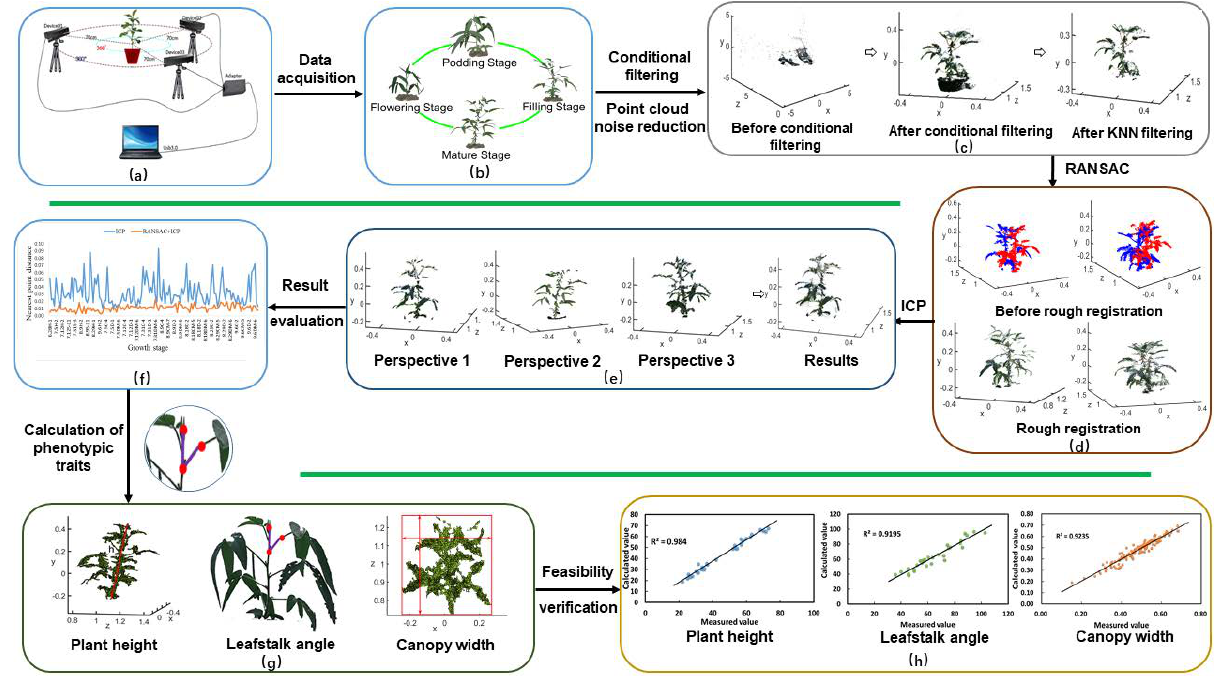
Figure 3. Overall framework for 3D reconstruction of soybean canopy and calculation of phenotypic